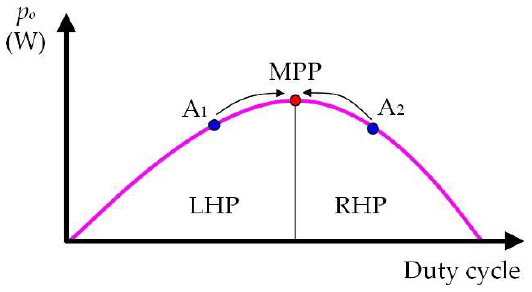
Figure 16. Schematic diagram of the hill-climbing algorithm.